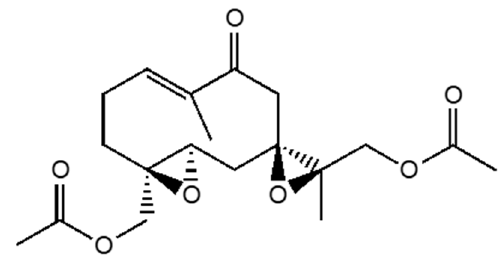
Figure 2. Structure of Sipaucin A.